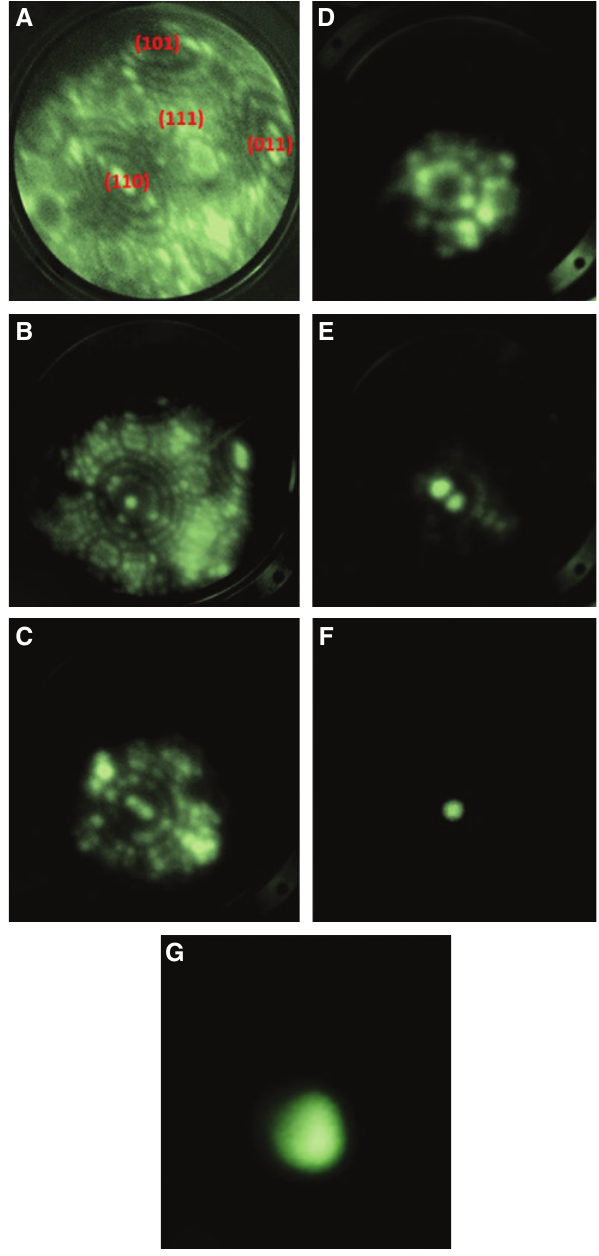
Figure 3: FIM image sequence showing the sharpening process on the tip apex. (A) The initial tip. (B–E) Intermediate stages of the tip during the sharpening process. (F) The SAT formation on the tip. (G) FEM image of the SAT shown in